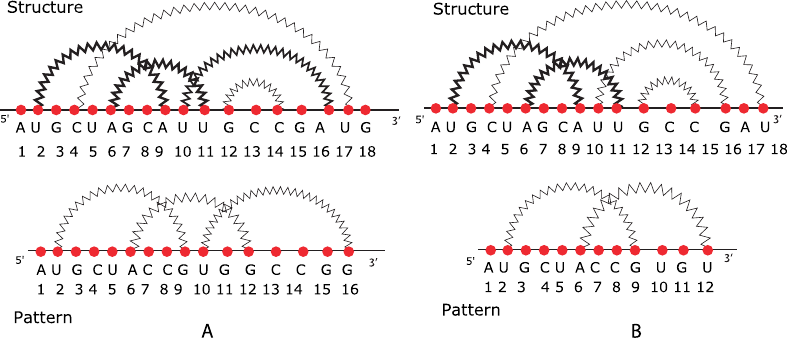
Figure 6: (A) A graphical example of APS problem and (B) an illustration of the problem with our restriction.